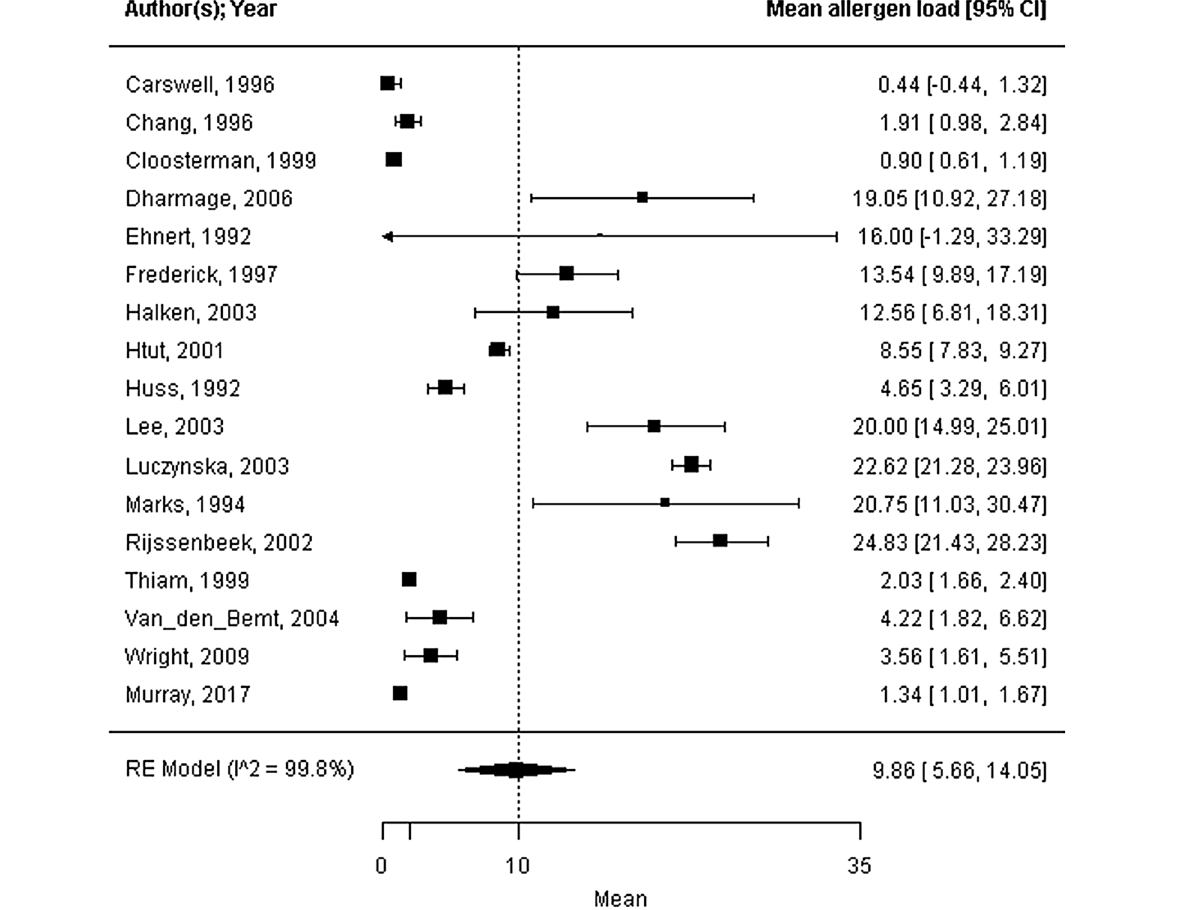
Fig. 2 Forest plot of the mite allergen load of the mattress at